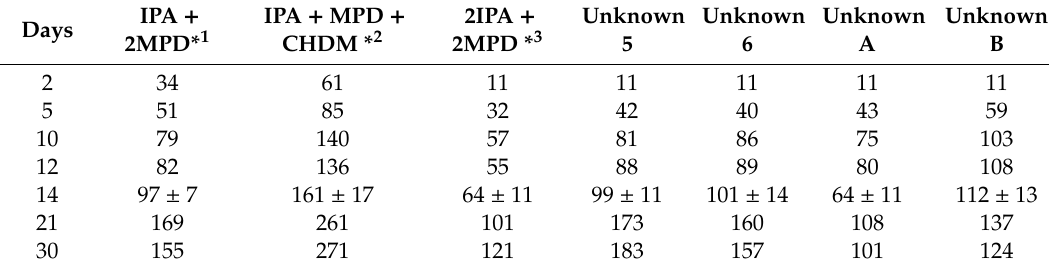
Table 4. Concentrations of tracked migrants from polyester coatings into 50% ethanol food simulant at 60 ◦ C. Results expressed in µ g / dm 2 . *1, *2, and *3, are listed as IPA + 2 MBO, IPA + MBO + COH and 2 IPA + 2 MBO in Paseiro-Cerrato et al. [33]. Unknowns 5 and 6 are listed in Paseiro-Cerrato et al. [33]. Unknowns A and B are tracked unidentified migrants in the migration